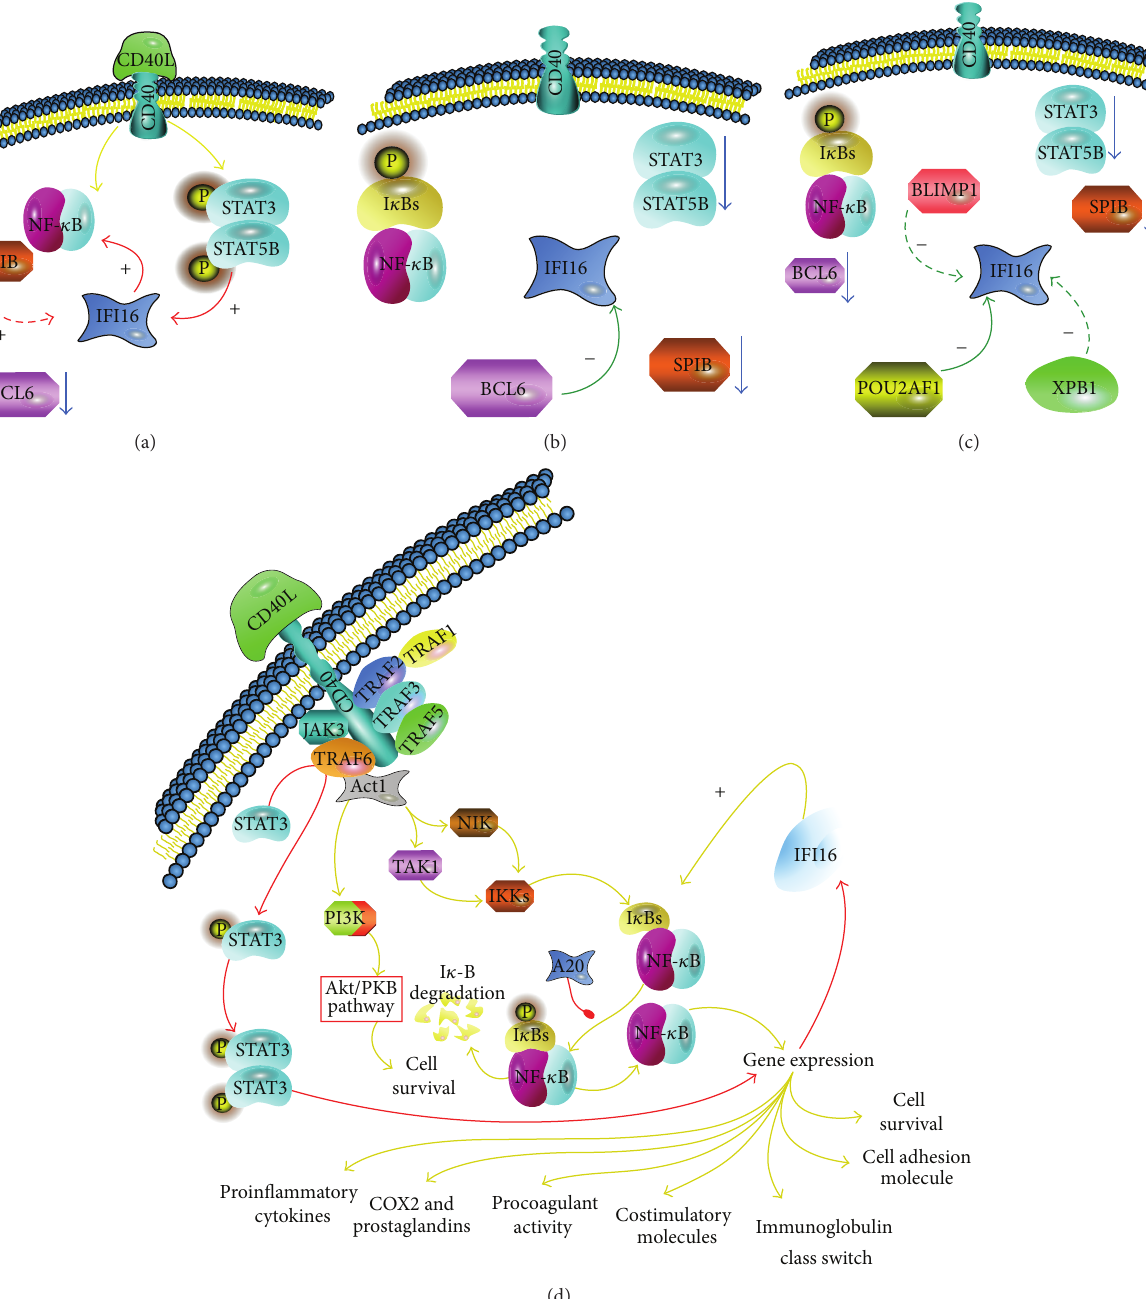
Figure 9: Hypothetical regulation of IFI16 during mature B-cell differentiation based on the present study. Interactions in na¨ıve and memory (a), germinal center (b), and plasma cells (c) are described. In panel (d), details regarding the effects of CD40 signaling on IFI16 are depicted. Solid arrows indicate possible direct effects while dashed arrows indicate possible indirect